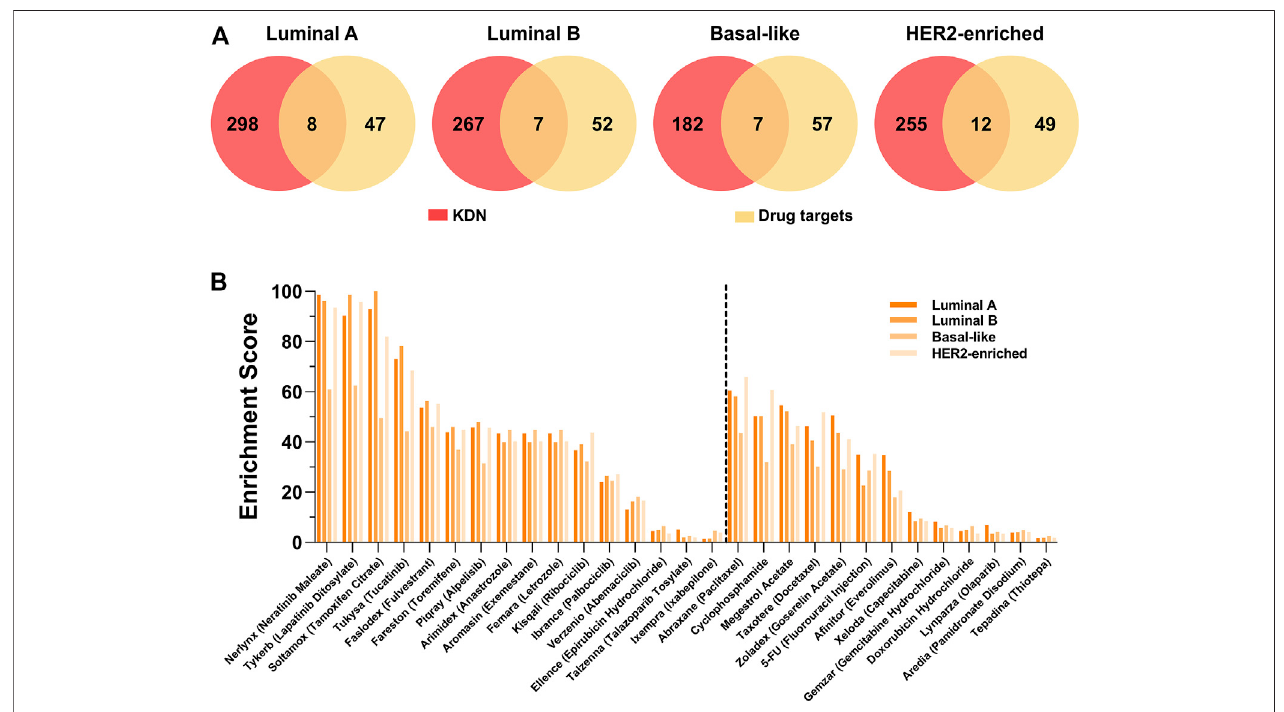
FIGURE5| Drugtargetanalysis. (A) TheVenngraphofthetargetsof29breastcancerdrugsandgenesintheKDN. (B) Theenrichmentscoresof29breastcancer targeted drugs.